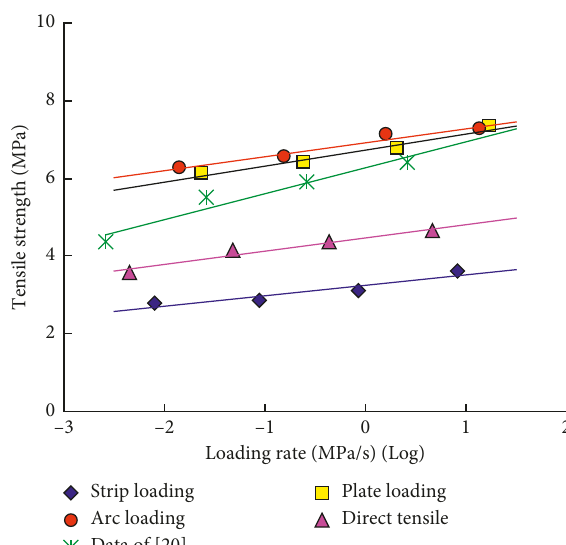
Figure 14: Comparison of sandstone tensile strengths under different loading methods. Table 3: Comparison of the indirect tensile strength and direct tensile strength under different loading methods. Log(loading rate)